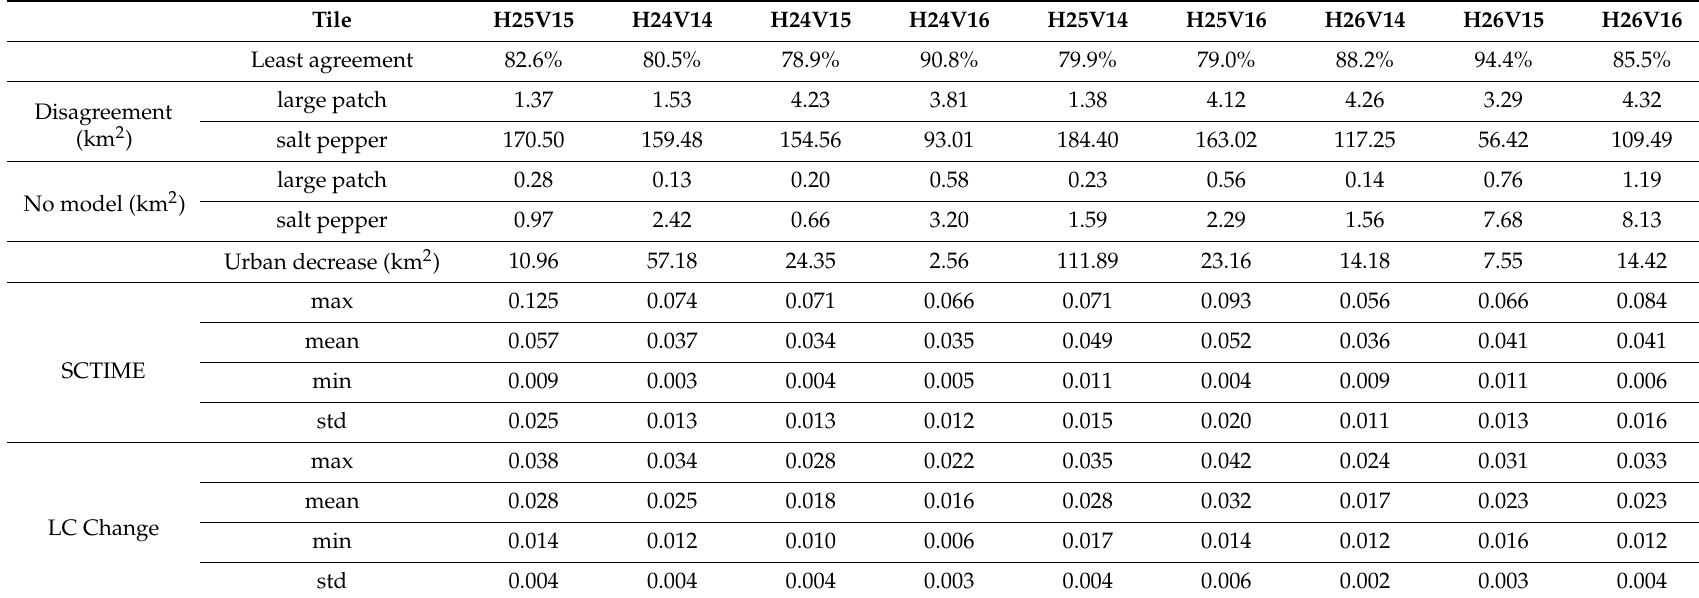
Table 3. Results of indices for H25V15 and its neighboring